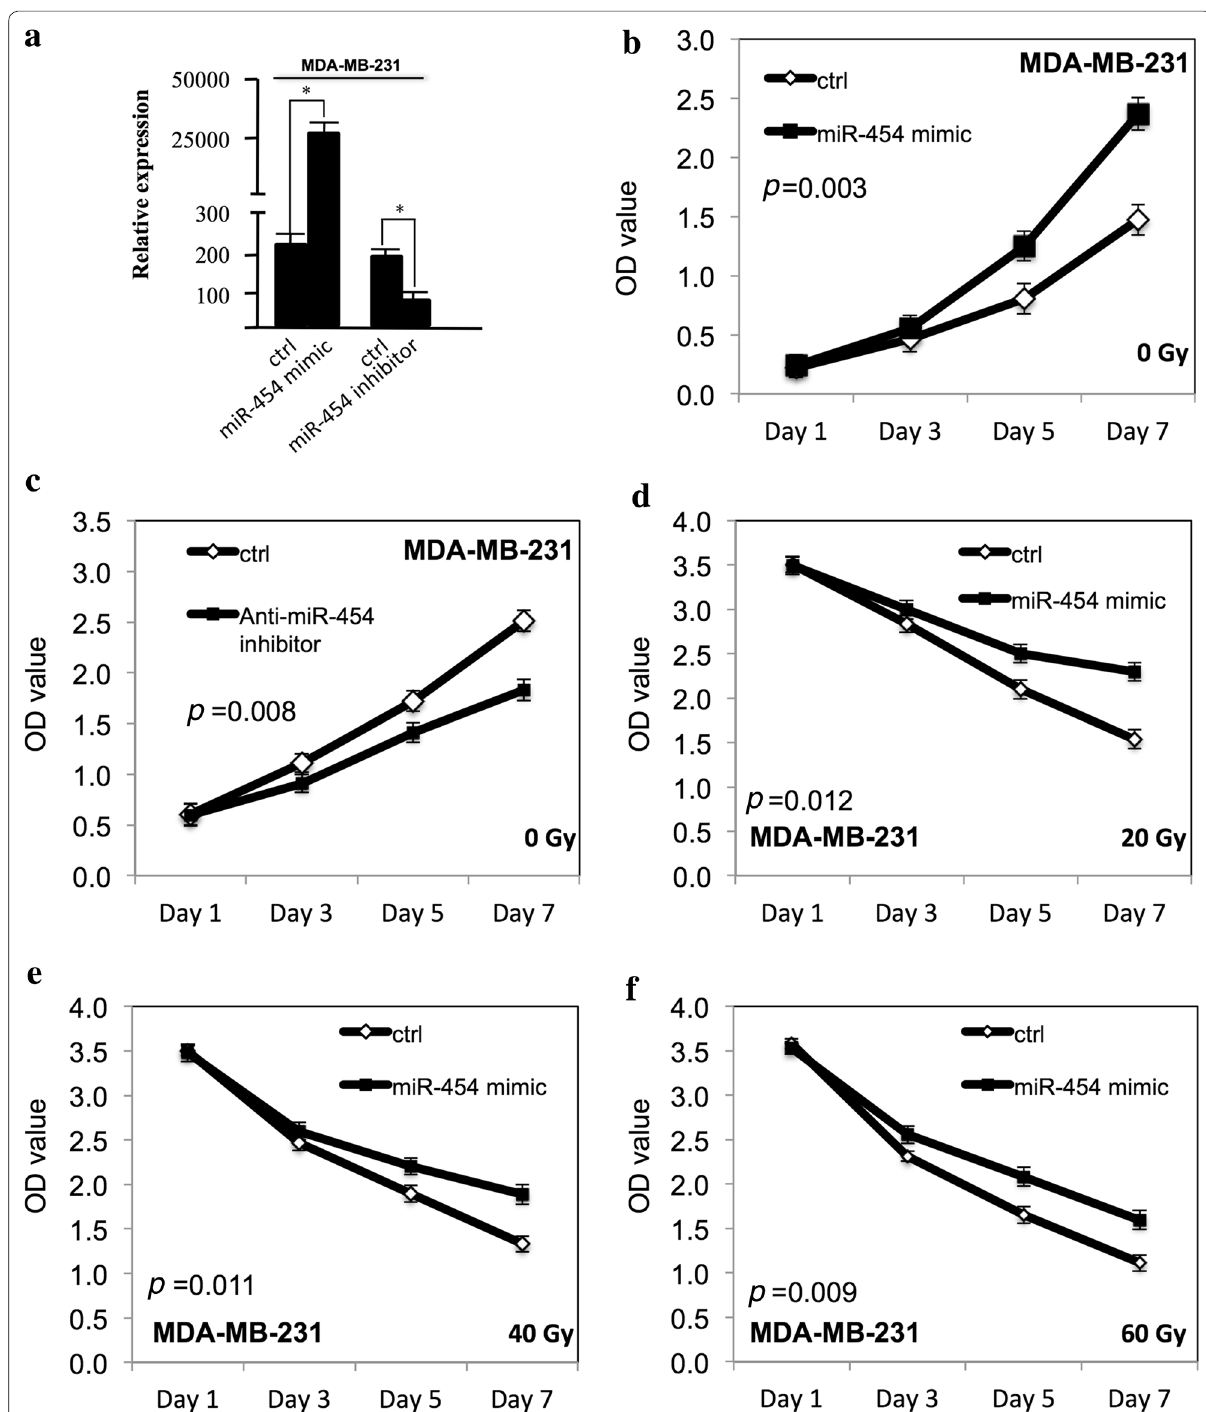
Fig. 1 miR-454 increased the proliferation of MDA-MB-231 cells and improved the survival at ionizing radiation. a The miR-454 expression level was determined by qRT-PCR in MDA-MB-231 cells transfected with either miR-454 mimic or anti-miR-454 inhibitor. b The proliferation of MDA-MB-231 cells after transfection of miR-454 mimic. c The proliferation of MDA-MB-231 cells after transfection with anti-miR-454 inhibitor. d The proliferation of MDA-MB-231 cells after miR-454 overexpression at 20 Gy. e The proliferation of MDA-MB-231 cells after miR-454 overexpression at 40 Gy. f The proliferation of MDA-MB-231 cells after miR-454 overexpression at 60 Gy. All experiments were performed in